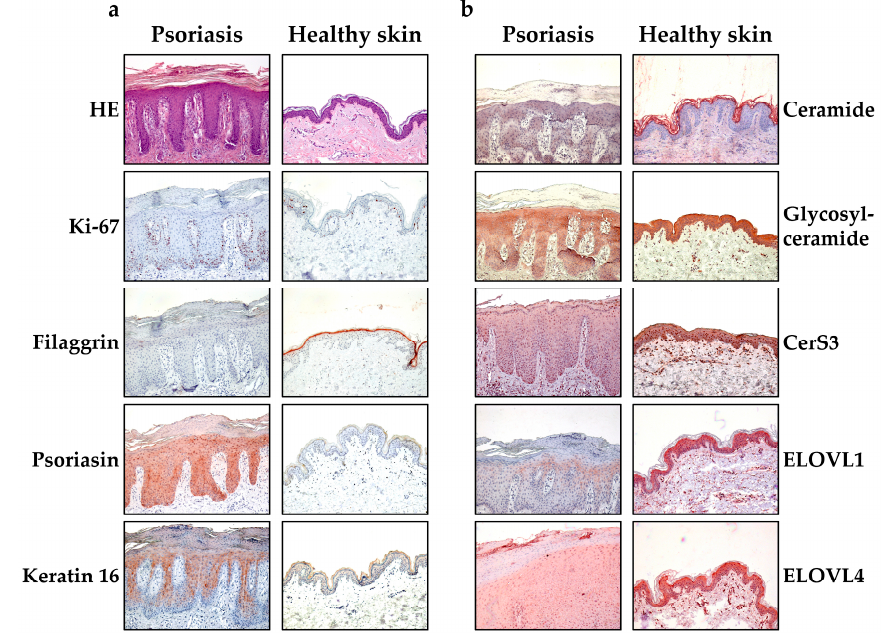
Figure 2. Expression of ceramides and enzymes for the generation of long chain free fatty acids (FA) ceramides in lesional skin of psoriasis patients. ( a ) Formalin- fixed and paraffin embedded tissue of lesional skin and healthy skin was HE stained. Furthermore Ki-67, filaggrin, keratin 16 and psoriasin was stained. ( b ) Formalin- fixed and paraffin embedded tissue of lesional skin and healthy skin was stained to detect ceramides, glucosylceramides, ceramide synthase 3 (CerS3) and elongases (ELOVL 1 and